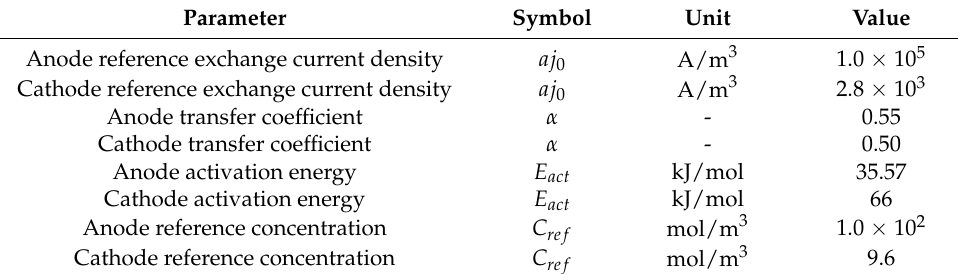
Table 2. Electrochemical